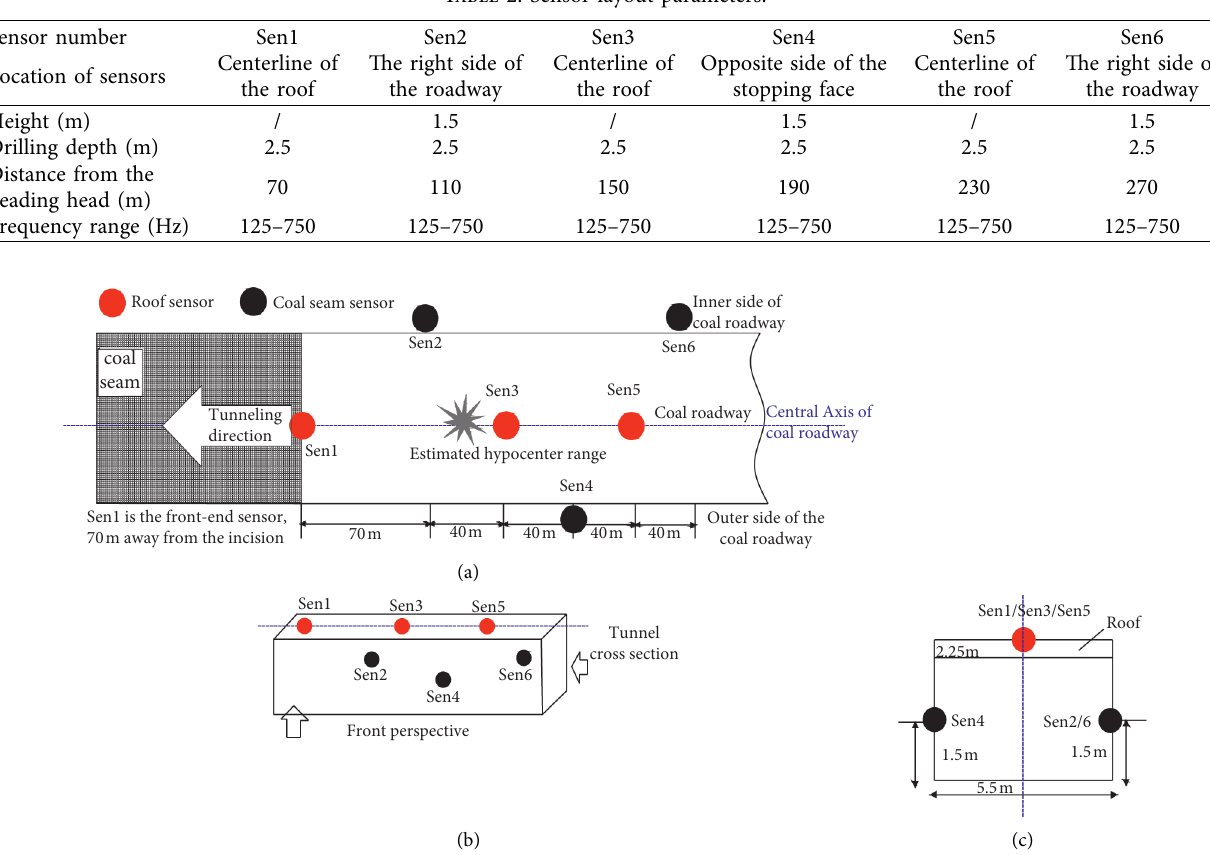
Figure 2: Three views of sensor layout in 8005 Haulage roadway. (a) Layout diagram of roadway trend sensor. (b) Front perspective of roadway sensor layout. (c) Roadway sectional